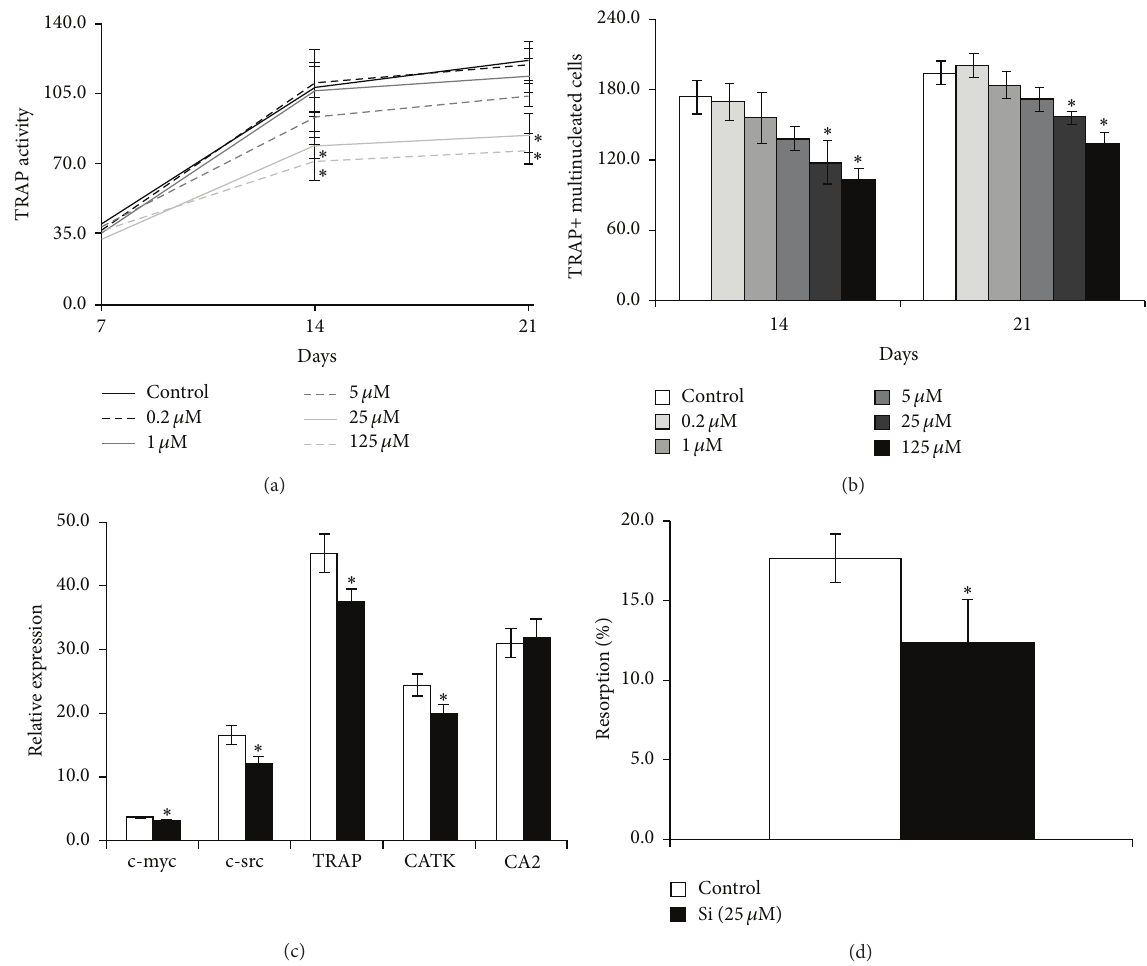
Figure 4: Effects of Si on the differentiation and function of CD14+ cells. (a) TRAP activity, determined by p NPP hydrolysis assay; (b) number of TRAP+ multinucleated cells, determined by TRAP and hematoxylin staining; (c) qPCR analysis of cell cultures maintained in the absence (control) or presence of (25 𝜇 M) Si; (d) calcium phosphate resorbing activity of cell cultures. ∗ Significantly different than the